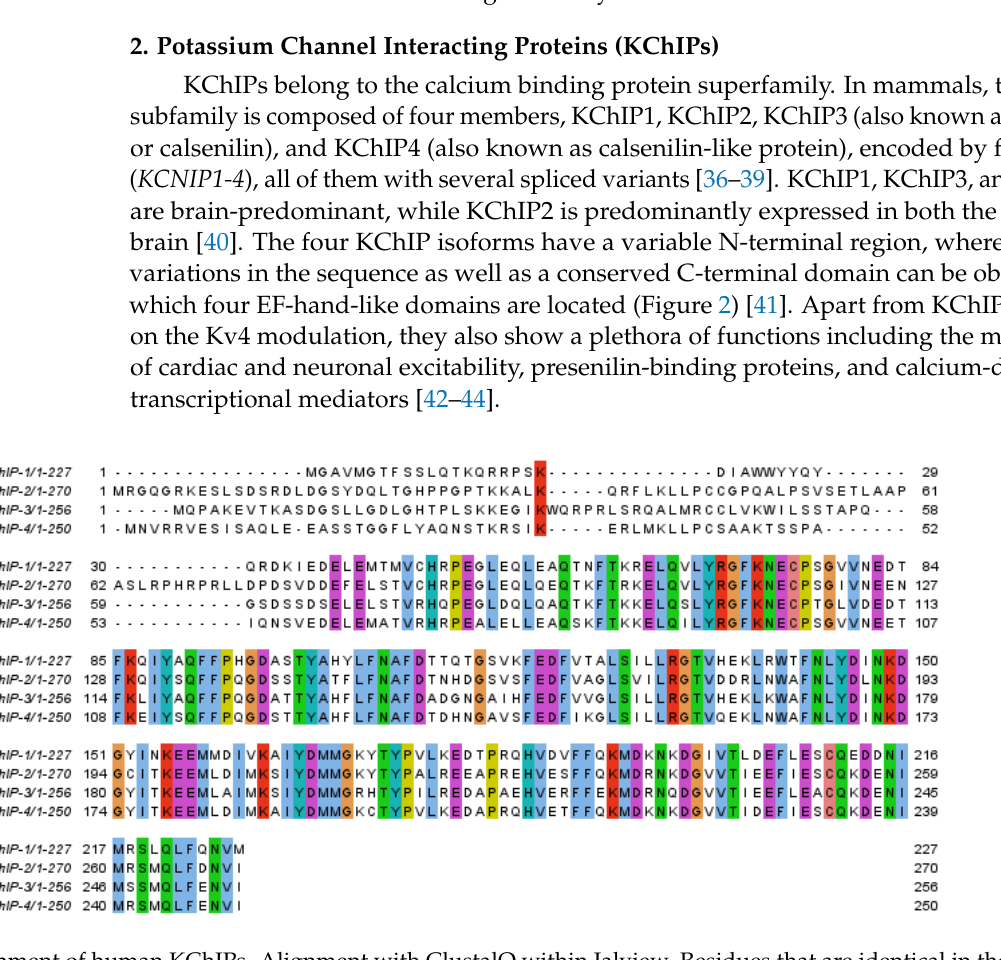
Figure 1. Alignment of human K V 4. Alignment with Clustal within Jalview. Residues that are identical in the four sequences are boxed [16].